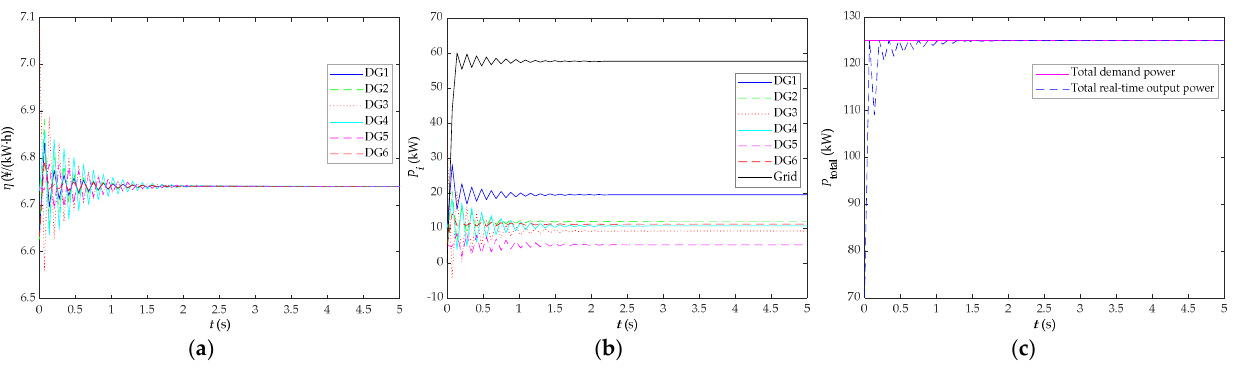
Figure 14. The change curves of variables of the system when ζ is set as 1: ( a ) change curves of each DG’s ICR; ( b ) change curves of each DG’s active output and grid output power; ( c ) change curves of the cumulative sum of each DG’s active output and grid output power as well as total demand power.